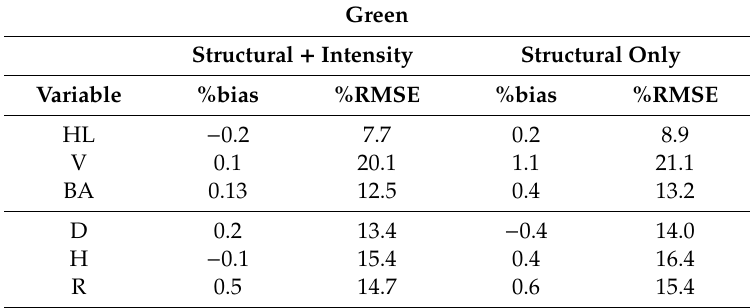
Table 8. %RMSE and %bias results for structural only and combination of structure and intensity models derived from the Green (532 nm) M-ALS wavelength. Green